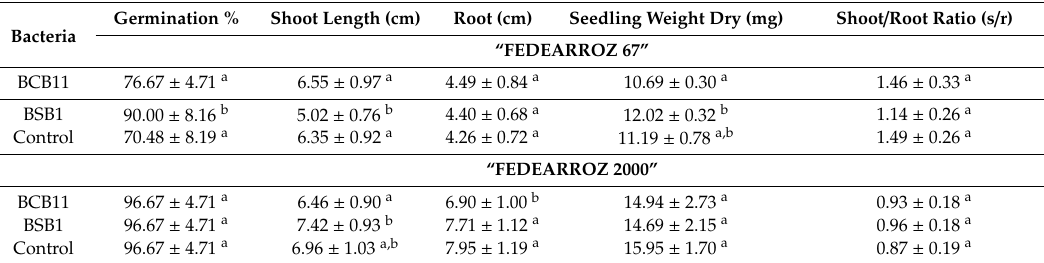
Table 2. Seed germination and seedling